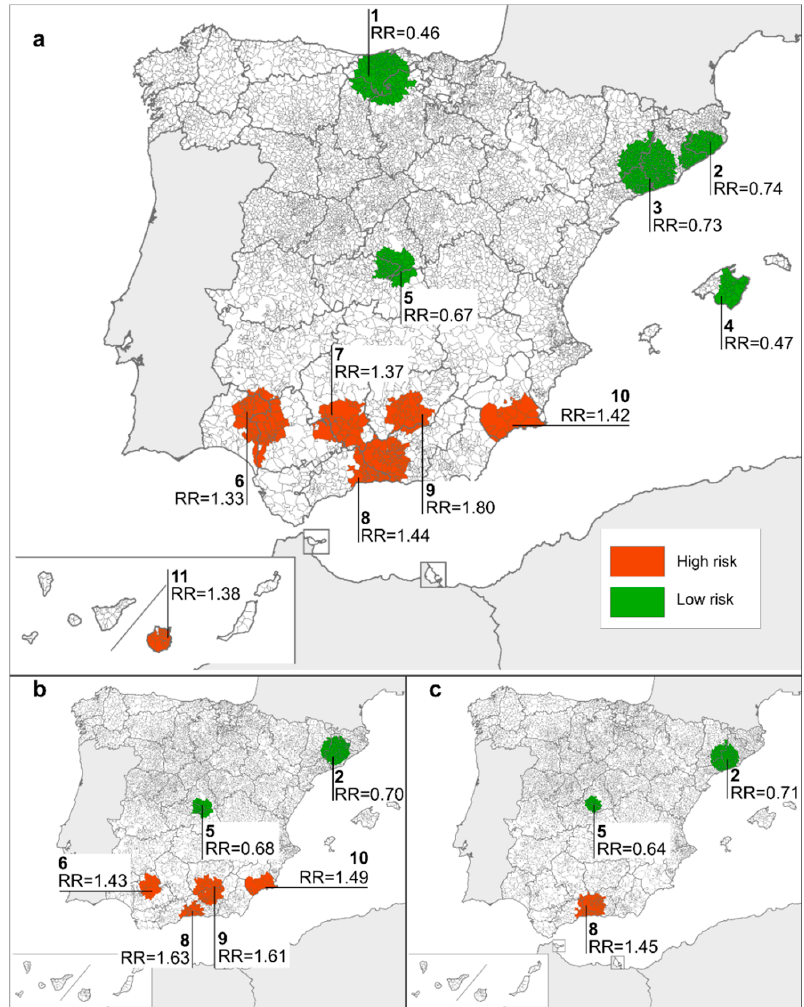
Figure 4. Rare congenital-anomaly mortality clusters for: ( a ) both sexes, ( b ) males, ( c ) females. Clusters are named according to Spanish provinces involved: 1 = Cantabria, Burgos, Palencia; 2 = Girona, Barcelona; 3 = Barcelona, Tarragona, Lleida; 4 = Mallorca; 5 = Madrid, Toledo; 6 = Huelva, Seville; 7 = Córdoba, Seville; 8 = Granada, Málaga; 9 = Jaén; 10 = Murcia; 11 = Gran Canaria.